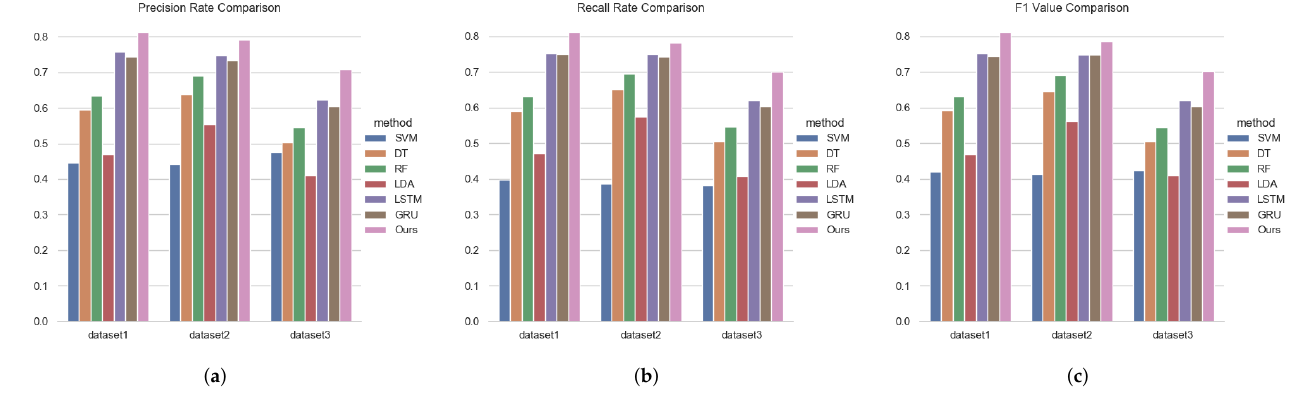
Figure 6. Overall result comparison. The three figure, respectively, show the comparison of ship classification effects under different metric methods. Different colors in each figure represent differ- ent methods. ( a ) Precision Rate; ( b ) Recall Rate; ( c ) F1